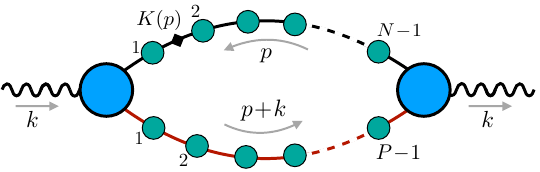
Figure 5 . Diagrammatic representation of eq. (3.93). There are two self-energy chains, the black one and the red one. The number of black self-energy insertions is N (cid:0) 1. There are in total N black lines in the loop, of which N (cid:0) 1 are standard propagators, and one corresponds to the insertion of K . The number of red self-energy insertions is P (cid:0) 1. There are in total P red lines in the loop, all correspoinding to standard propagators. If ‘ is the line where K is located, the equivalence class [ ‘ ] t is the set of all black pion lines explicitly drawn in this diagram. By contrast, the equivalence class [ ‘ ] s is the set of all (black and red) pion lines explicitly drawn in this